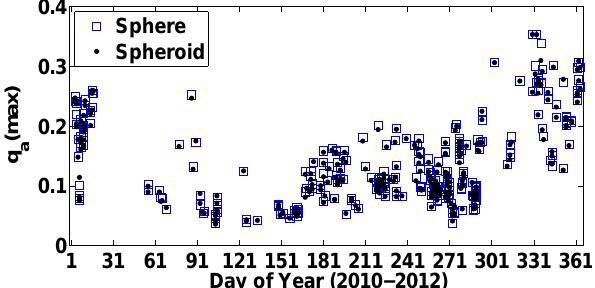
Fig. 1. Comparison between the maximum values of the retrieved aerosol polarized phase function, q a ( max ) , for two assumptions on the shape of the particles, spheres (blue empty squares), and spheroids (black solid circles).